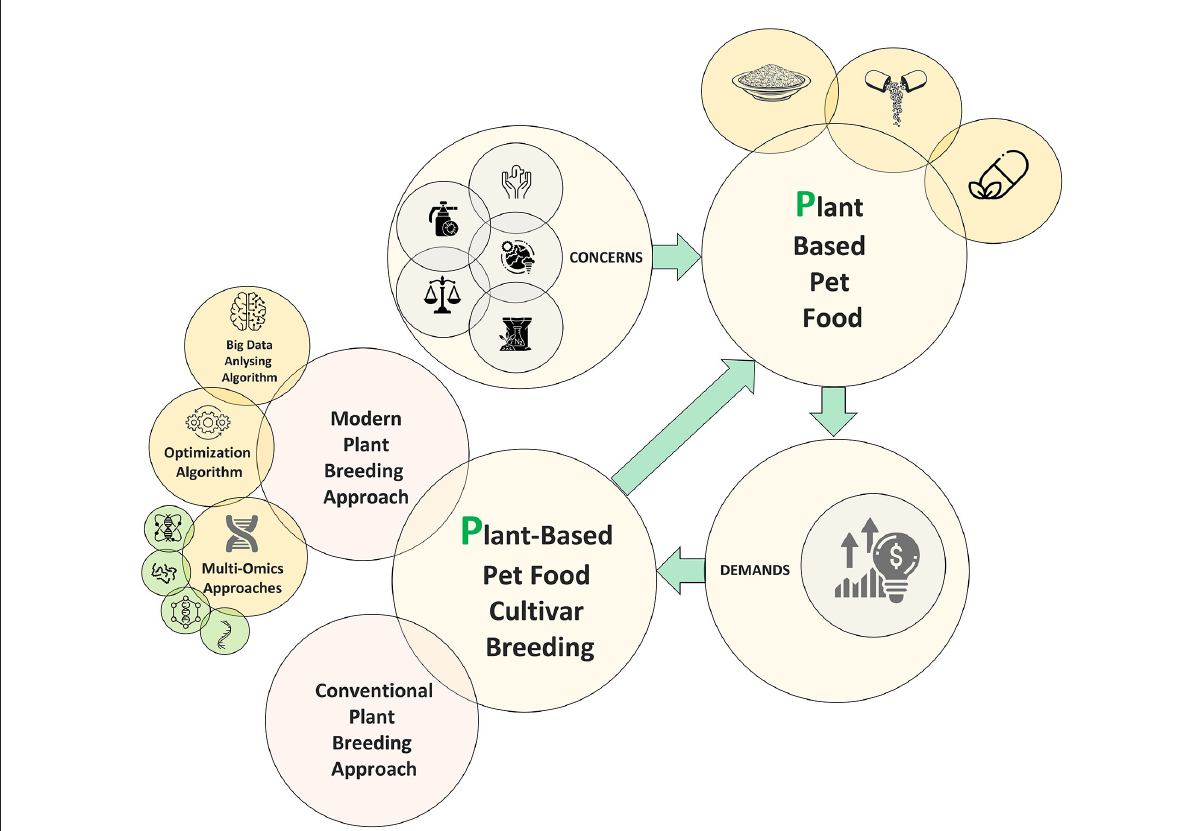
FIGURE1 Schematic view of plant cultivar breeding pipeline for plant-based pet food